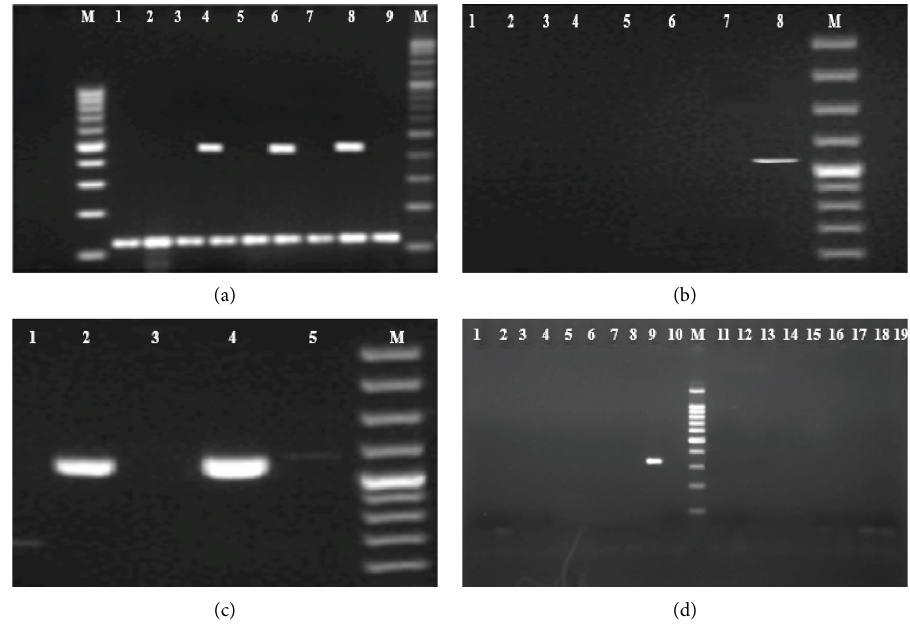
Figure 4: (a) Ladder size:1000bp, line 4, 6, and 8 cdt1 positive (411bp); lines 1–9 uidA positive (102bp). (b) Ladder size:1000bp, line 8 cdt2 (556 bp). (c) Ladder size: 1000bp, line 2, 4, and 5 cdt3 (555bp). (d) Ladder size: 1000bp, line 9, cdt4 positive (350